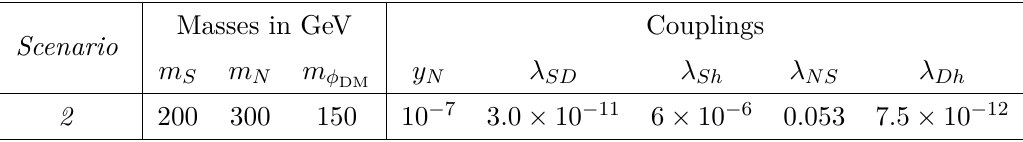
Table 3 . The choices of masses and couplings for Scenario-2